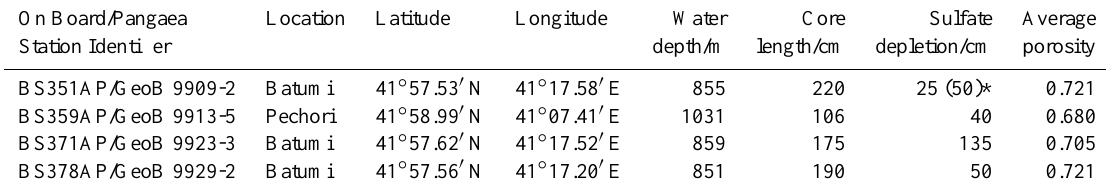
Table 1. Station information, sulfate depletion depth below core surface, and average core porosity. On Board/Pangaea Location Latitude Station Identifier